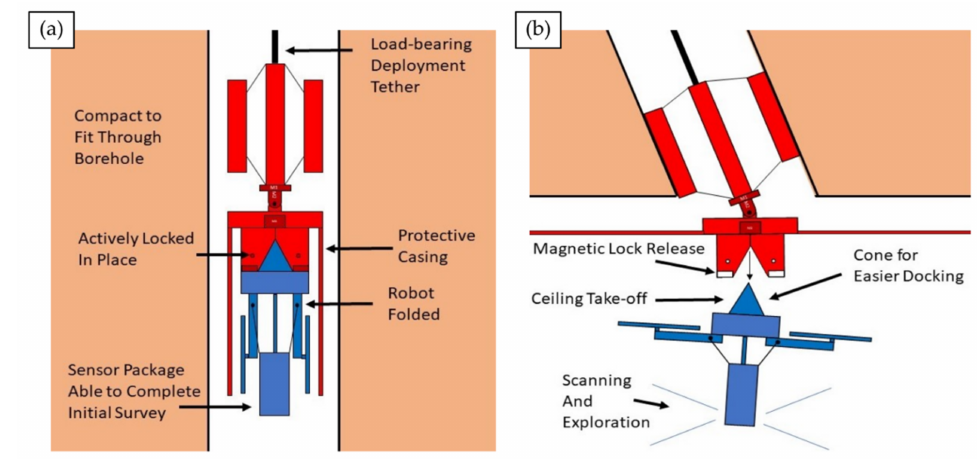
Figure 8. Folding UAV PROMETHEUS for subterranean inspection [156] can enter boreholes ( a ) to explore inaccessible voids ( b ) of potential benefit for probing hidden shafts in